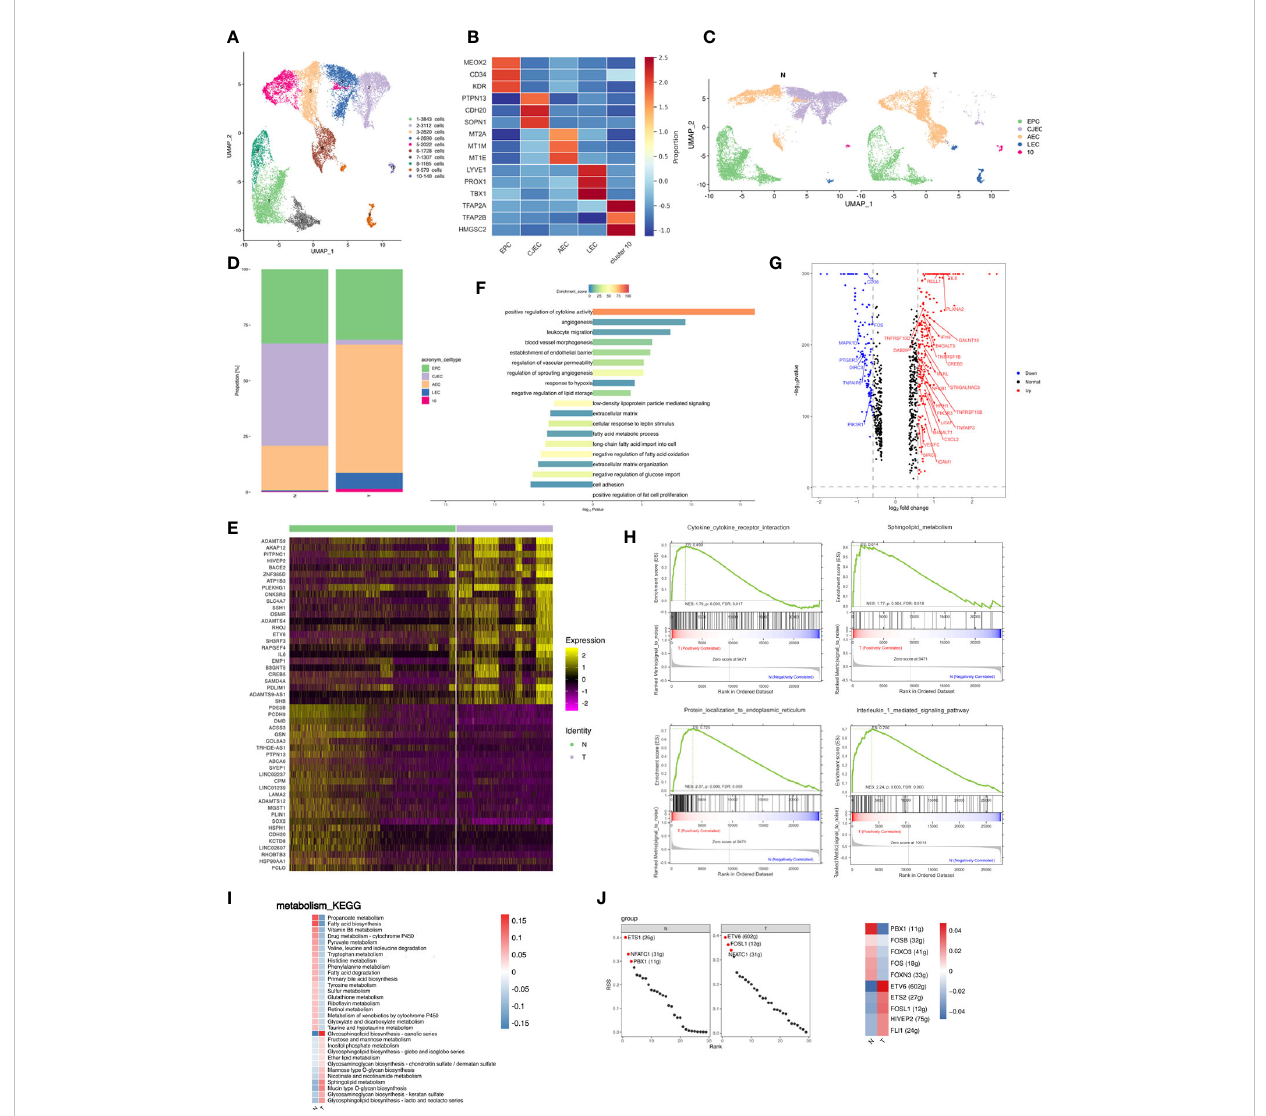
FIGURE 3 Breast cancer promotes the in fl ammatory pro fi le of endothelial cells in adipose tissues. (A) UMAP plot of 10 clusters of endothelial cells from the 6 samples pro fi led in this study, with each cell color coded to indicate the associated subclusters and cell numbers. (B) Heatmap showing the expression of endothelial subpopulation marker genes in each cluster. The color changes from blue to red, indicating a low to high fold change. (C) UMAP plot of all endothelial subpopulations annotated in each group, with each cell color coded to indicate the associated subclusters. (D) The relative ratio of endothelial cells in N and T group shown using bar plots, with each cell color coded to indicate the associated subclusters. (E) Heatmap showing the top 25 differential expression genes (up- or down-regulated). The color changes from blue to red, indicating a low to high fold change. (F) Barplot showing the signi fi cance levels of the top 10 most signi fi cantly enriched pathways in all DEGs. The left side of the coordinate axis represents the enriched functional pathway of down-regulated genes; The right side of the coordinate axis represents the enriched functional pathway of up-regulated genes. (G) Expression of genes (N versus T) involving in in fl ammatory (GO:0006954) in endothelial cells. (H) The top 4 GSEA analysis results of angiogenesis associated endothelial subpopulation. (I) Heatmap indicating the enrichment of metabolism signaling pathway on all endothelial cells in N and T group. (J) The regulon speci fi city score (RSS) ranking plot of top 3 TFs in all endothelial cells in N and T group. The abscissa represents the ranking, and the ordinate represents the RSS score. The regulator with higher RSS may be related to the speci fi city of this cell group (left). Heatmap showing the regulon activity in N and T group. Rows represent different regulons, and columns represent different cell populations. The color changes from blue to red, indicating a low to high RSS speci fi city score. The higher the RSS score, the stronger the speci fi city of regulon in this cell group (right). The number of target genes shown in